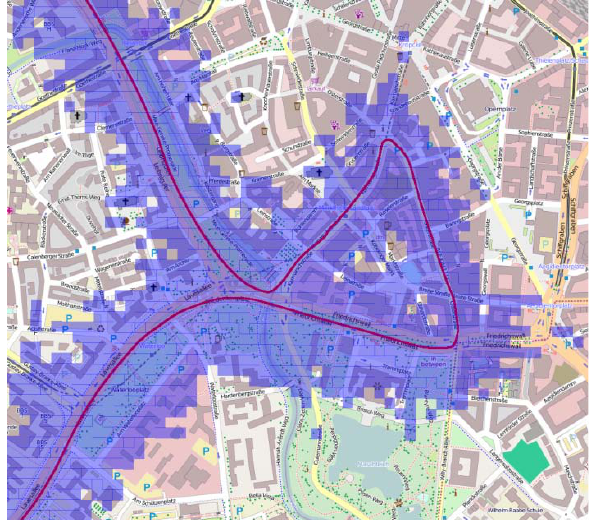
Figure 3. Tiled point cloud dataset and vehicle